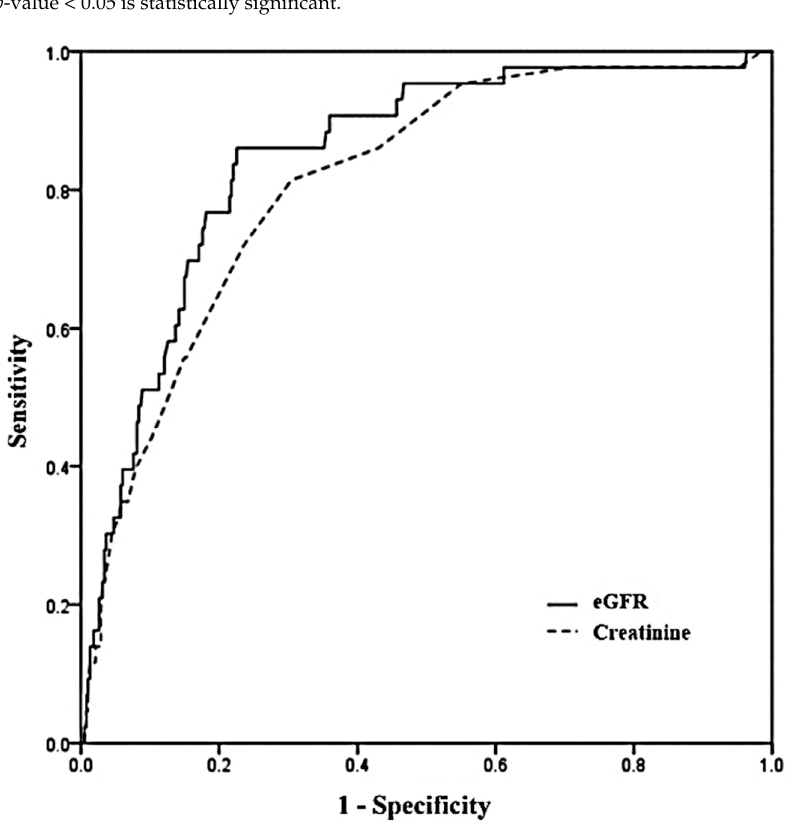
Figure 4. Receiver operating characteristic (ROC) curves for eGFR and creatinine. Areas under the curve with 95% confidence intervals was 0.846 (0.809–0.879) for eGFR and 0.811 (0.771–0.848) for creatinine ( p = 0.033). eGFR: estimated glomerular filtration rate.